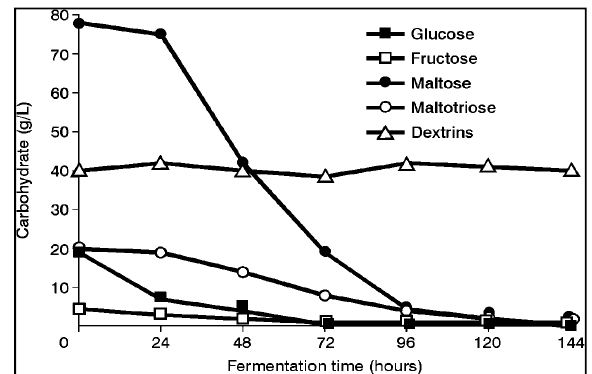
Figure 3. Uptake order of wort sugars by brewer’s yeast cultures [1].